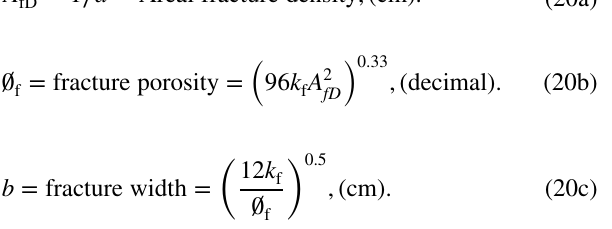
Fig. 8 Estimated average idealized matrix block height, producer well ‘B-1’